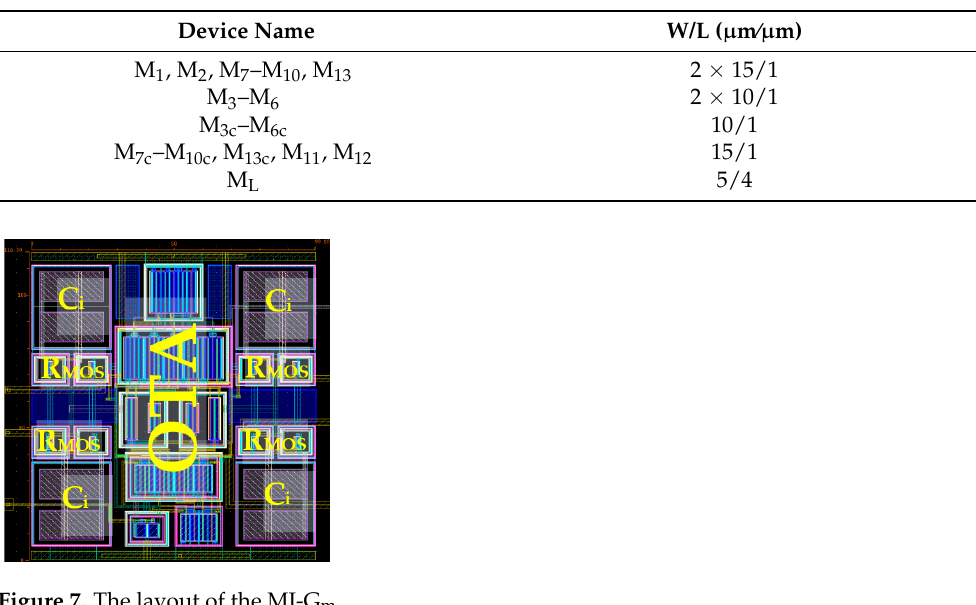
Figure 9. The simulated frequency responses of the proposed filter.